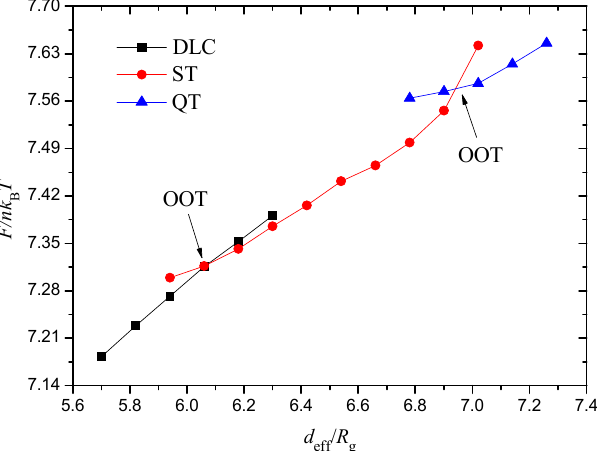
Figure 4. Free energy curves for the three morphologies (dumbbell-like cylinder (DLC), spherical concentric lamellae (SCL), and quadruple texture (QT)) in Figure 3. The order–order transition points are denoted as order–order transition (OOT).